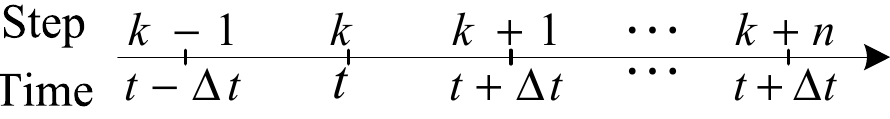
Figure 5. Schematic diagram of carrier tracking communication satellite.